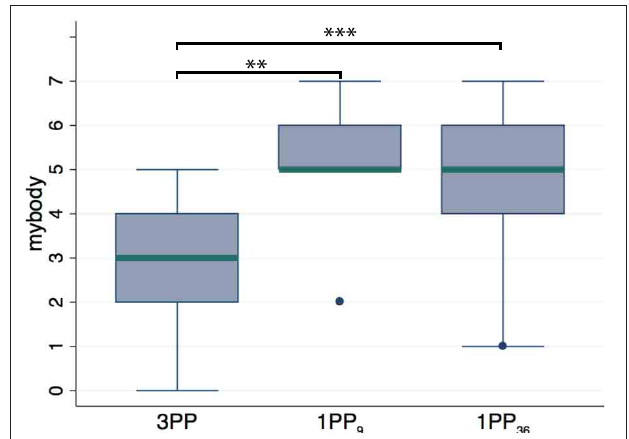
FIGURE 5 | Questionnaire data from experiment 2, in which we compare groups with different perspective levels. 3PP (9 subjects), 1PP 9 (9 subjects) and 1PP 36 (36 subjects, where all 1PP conditions were grouped together irrespectively of the visuotactile and head tracking modes). The significant difference in the mybody item showed that 1PP is an essential condition for the full body ownership illusion. ∗∗ p < 0 . 01, ∗∗∗ p < 0 . 001 from Mann–Whitney